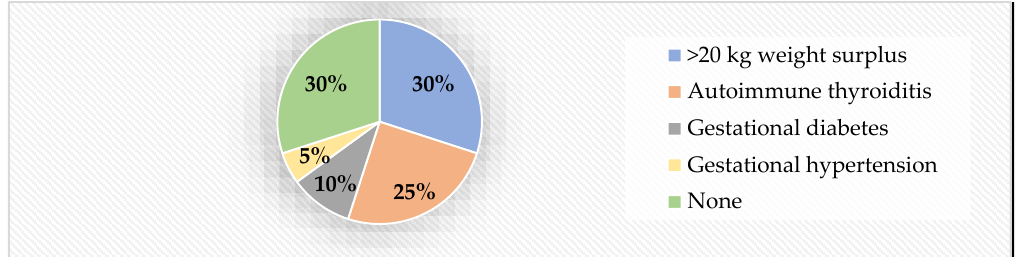
Figure 2. Mother ’s health during pregnancy, in obese children. Figure 2. Mother’s health during pregnancy, in obese